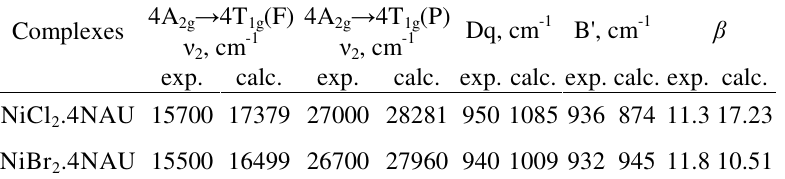
Table 3. Selected bands, assignments and spectral parameters for NiX